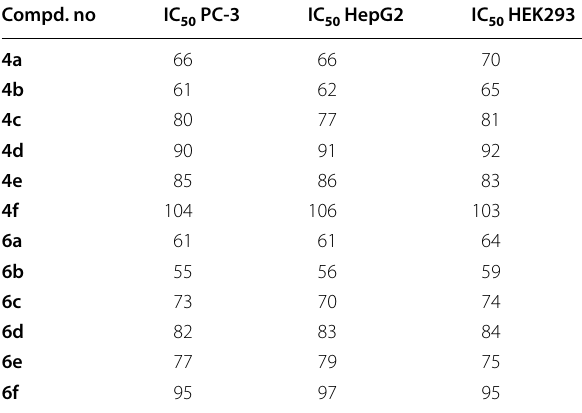
IC 50 values are presented as mean values of three independent experiments. SD were < 10%